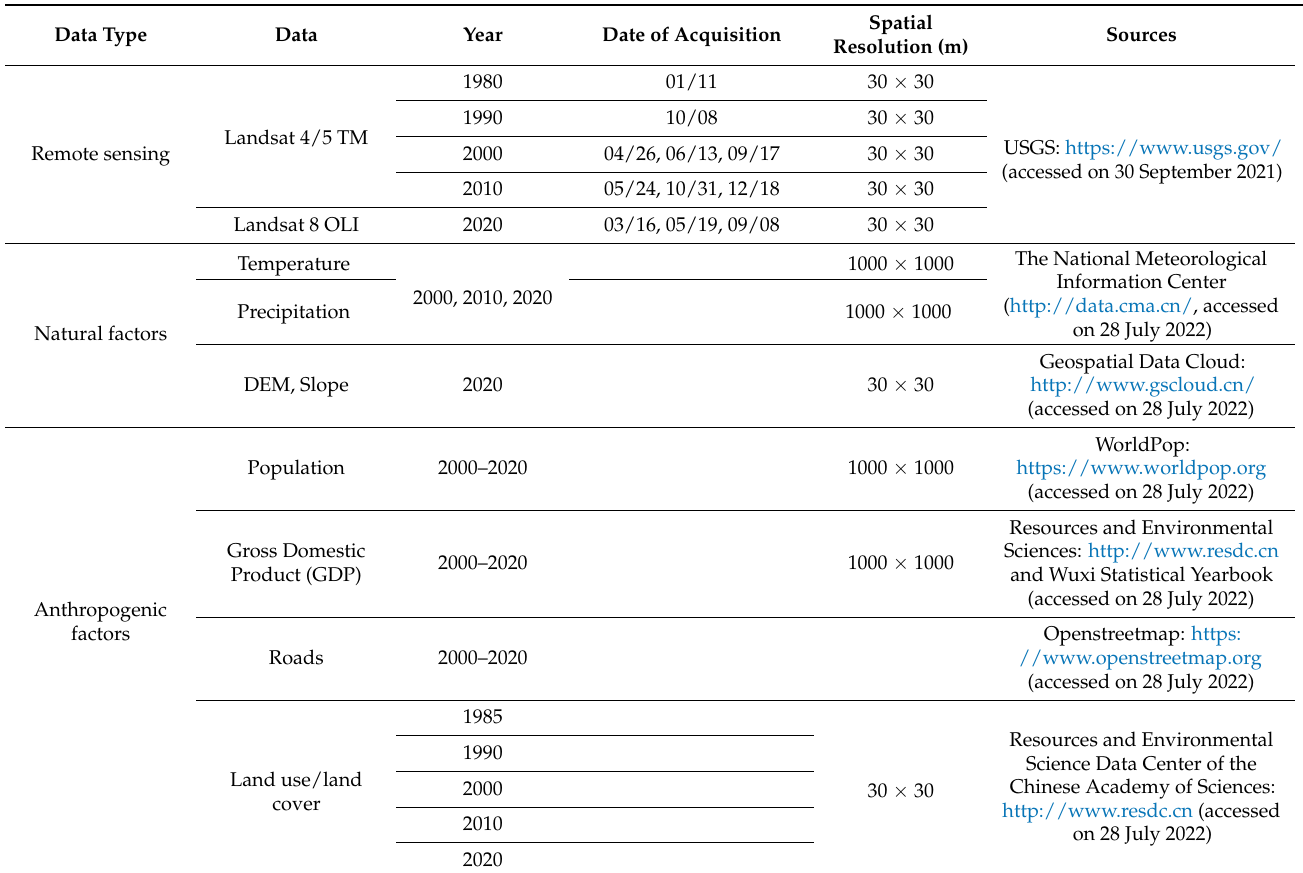
Table 1. Description of data used in the present